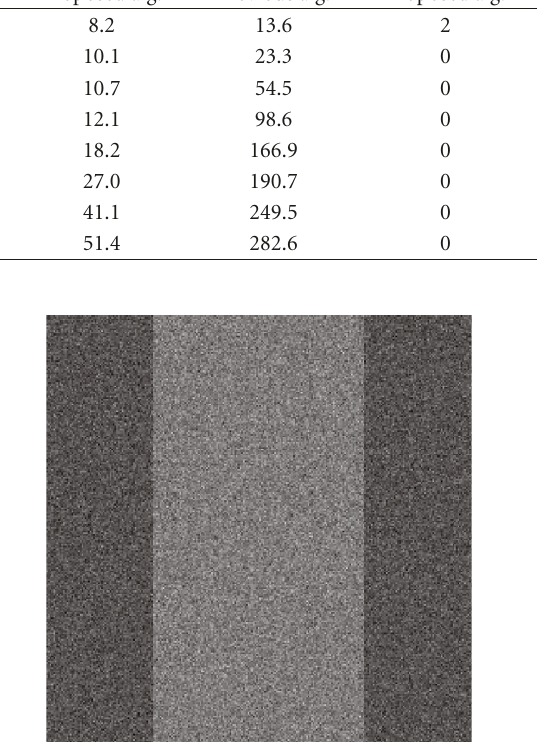
Figure 3: Test image containing two disjoint darker regions with a mean equal to 80 and variance equal to 100 separated by another brighter region with a mean equal to 100 and variance equal to